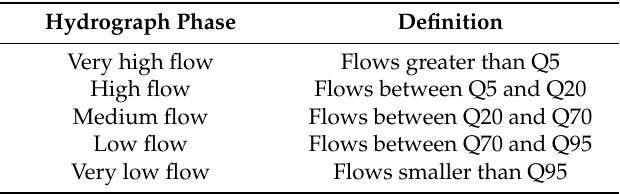
Table 4. Definition of five segments of different phases of the hydrograph.